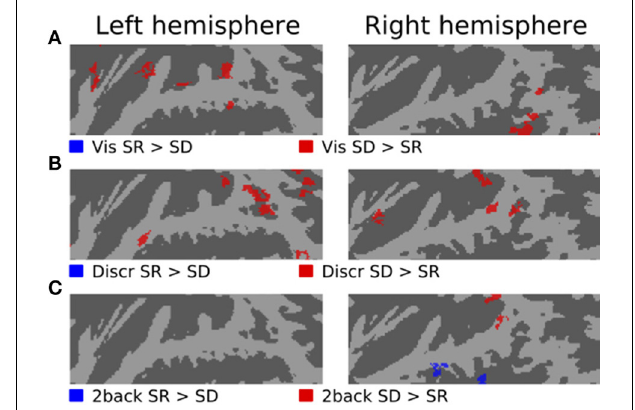
FIGURE 5 | Comparisons of activations during visual, discrimination and 2-back tasks with SR and SD